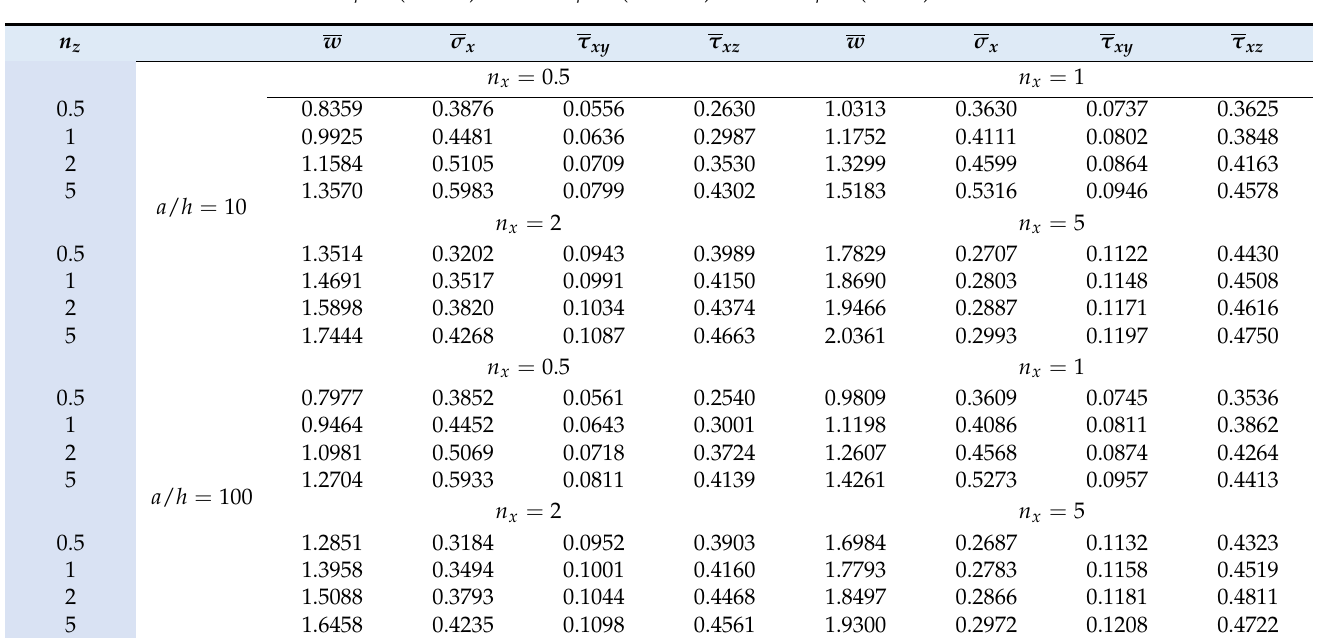
Influence of gradation indices on the non-dimensional maximum deflection (cid:16)